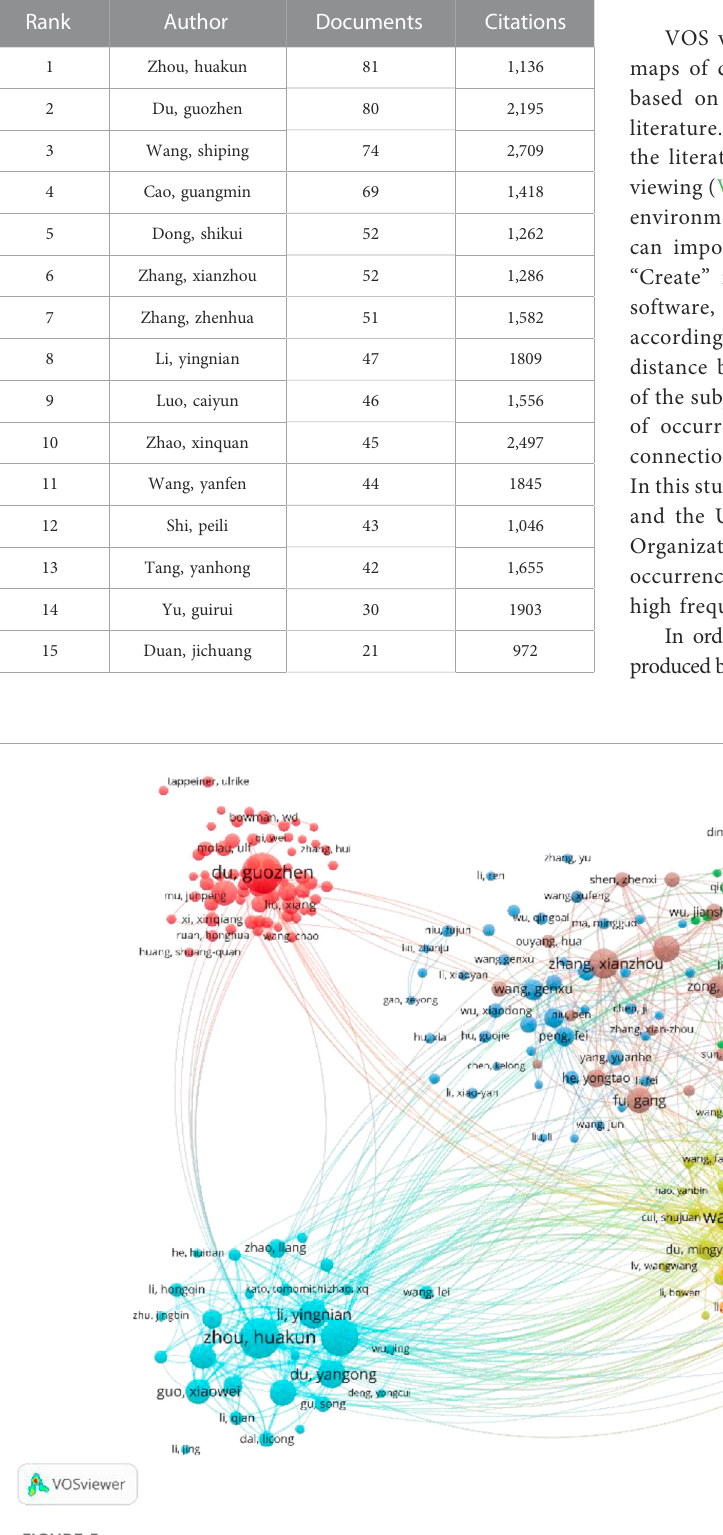
FIGURE 5 Collaborative network of researchers in the fi eld of alpine meadow